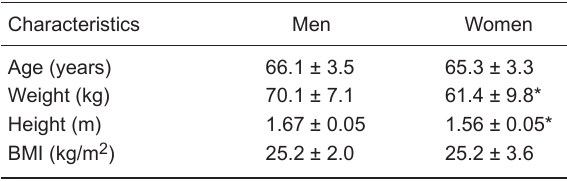
Table 1. Anthropometric characteristics of the volunteer groups.